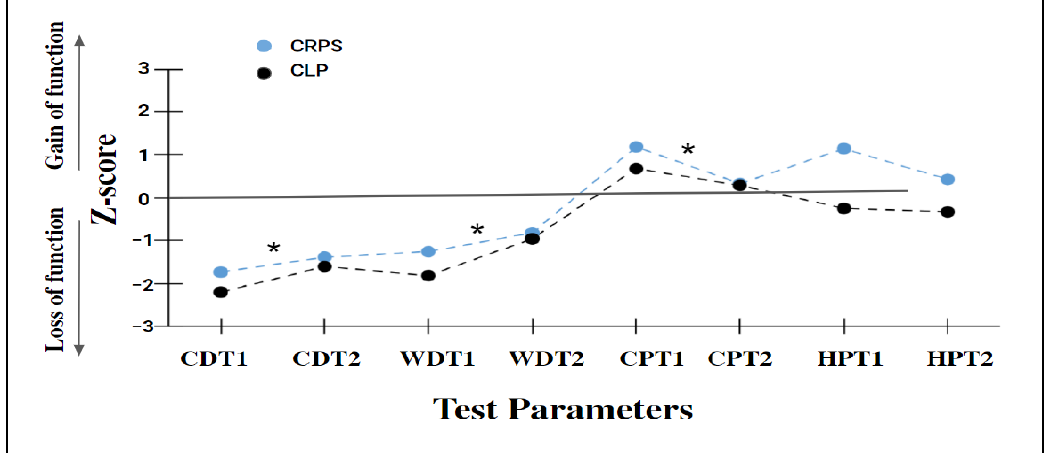
Figure 1. The thermal and pain threshold profile. Note. CRPS—Complex Regional Pain Syndrome; CLP—Chronic Limb Pain; CDT1—Cold Detection Threshold in the involved limb; CDT2—Cold Detection Threshold in the non-involved limb; WDT1—Warm Detection Threshold in the involved limb; WDT2—Warm Detection Threshold in the non-involved limb; CPT1—Cold Pain Threshold in the involved limb; CPT2—Cold Pain Threshold in the non-involved limb; HPT1—Heat Pain Threshold in the involved limb; HPT2—Heat Pain Threshold in the non-involved limb. Gain of function (z > 1); ‘loss of function’ (z < − 1). Pathologic gain of function (z > 1.96) pathologic loss of function (z < − 1.96). * p < 0.05- significant differences between the affected and non-affected sides in each